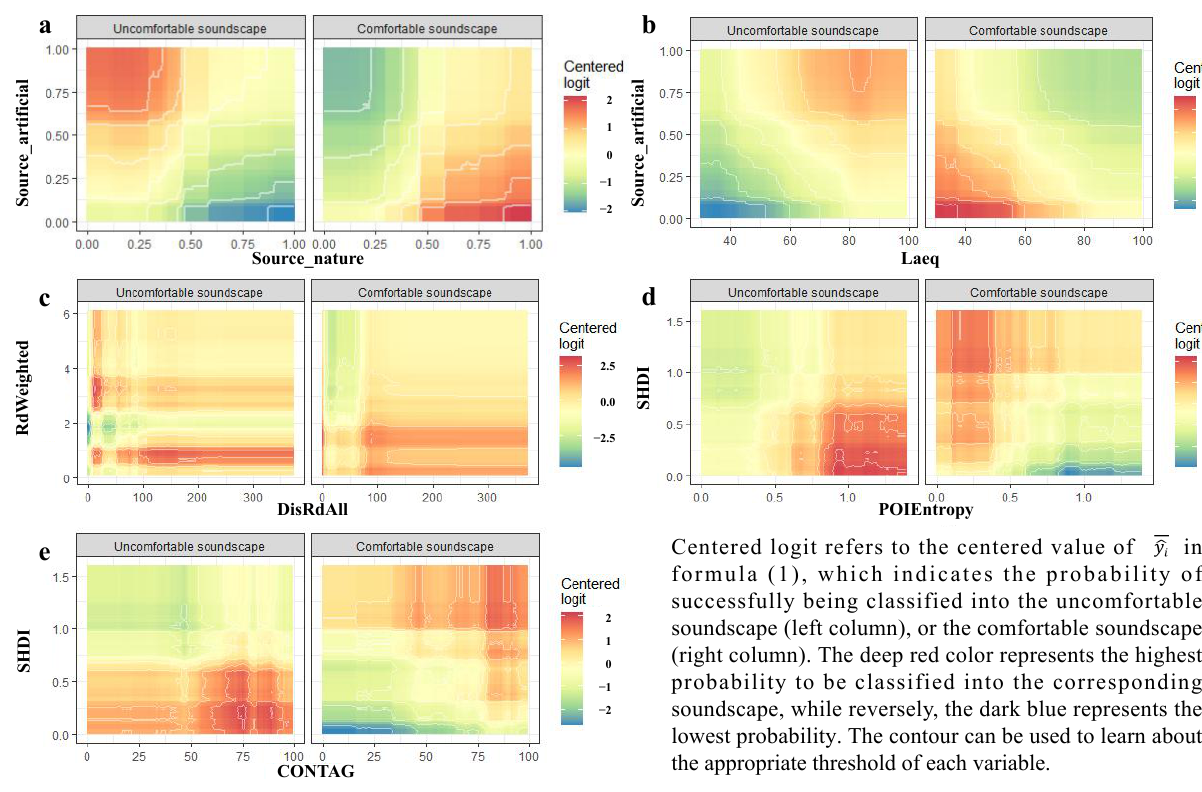
Centered logit refers to the centered value of in formula (1), which indicates the probability of successfully being classified into the uncomfortable soundscape (left column), or the comfortable soundscape (right column). The deep red color represents the highest probability to be classified into the corresponding soundscape, while reversely, the dark blue represents the lowest probability. The contour can be used to learn about the appropriate threshold of each variable. Figure 4. Partial dependence plot to understand the joint effect of paired predictors on model prediction